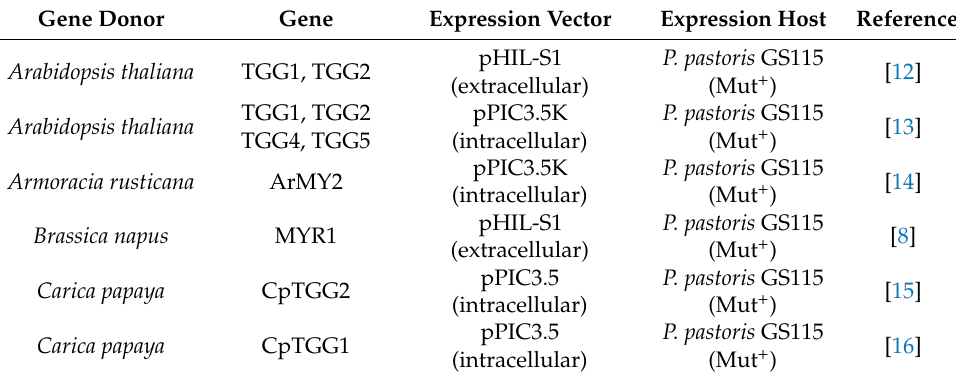
Table 1. Recombinant expression of various myrosinase genes in Pichia pastoris . Gene